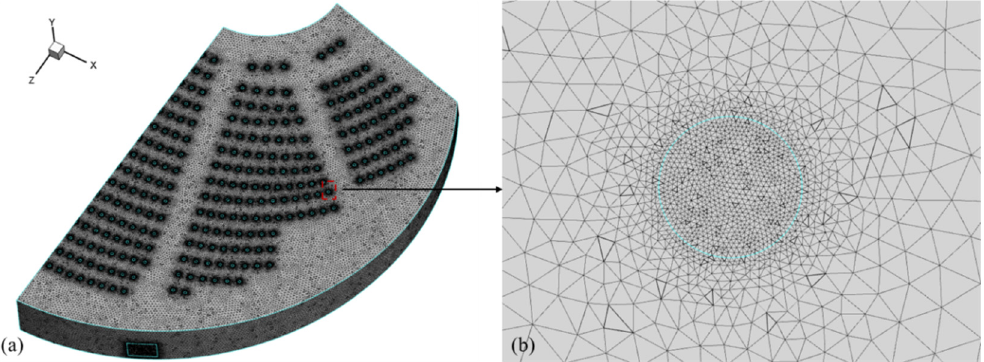
Figure 5. Schematic diagram of meshing. ( a ) Overall grid layout and ( b ) Local grid of air supply outlet under the seats. Table 1. Parameters of the mesh quality.